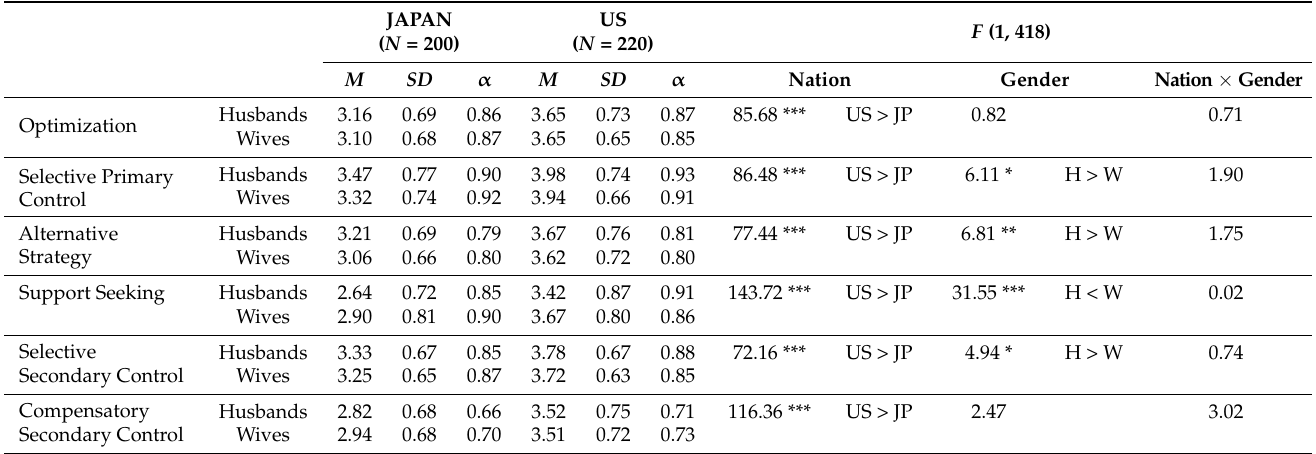
Table 6. Descriptive statistics and F values of mixed ANOVA of Nation by Gender on 6 OPS scale scores.